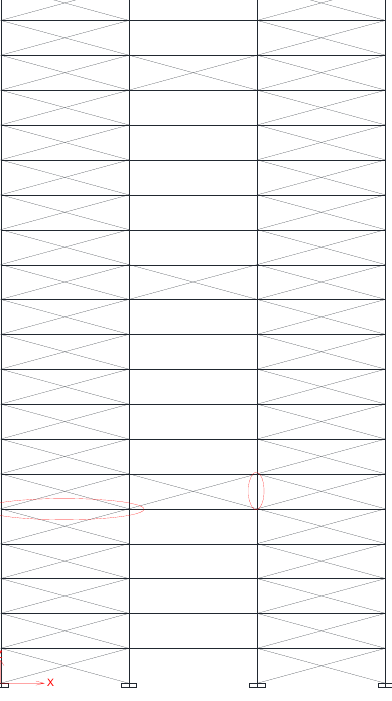
Figure 25. Schematic view of Step 2 damaged 20-story frame (by removing a beam and a column on the fifth floor). The removed beam and column are marked in the figure with a red circle.